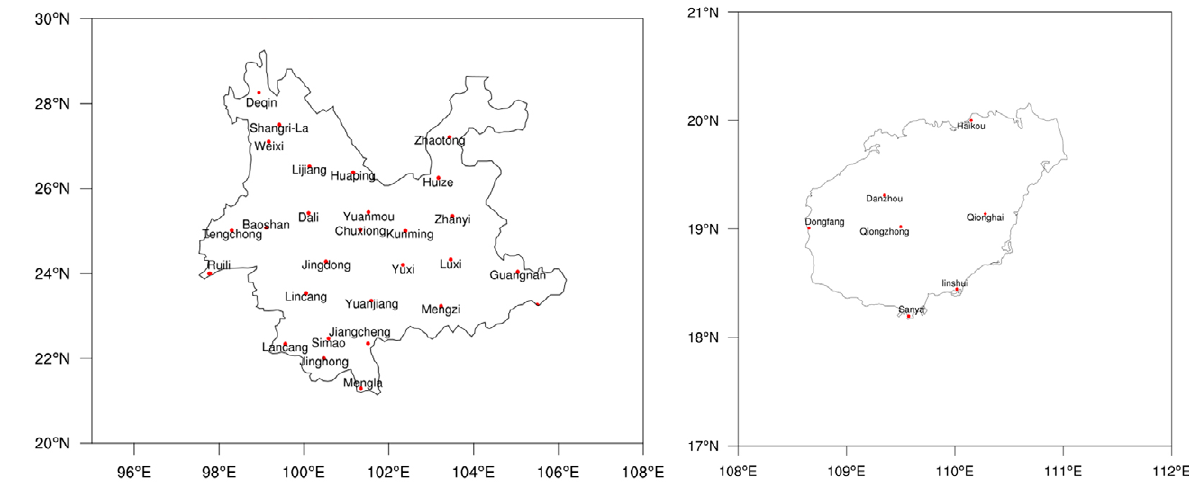
Figure 1. Locations of the 27 Yunnan (left) and 7 Hainan (right)